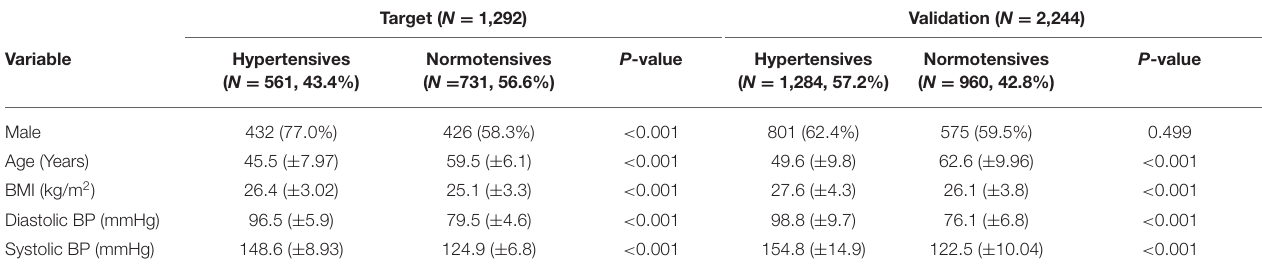
TABLE 1 | Demographic and phenotypic characteristics of target and validation